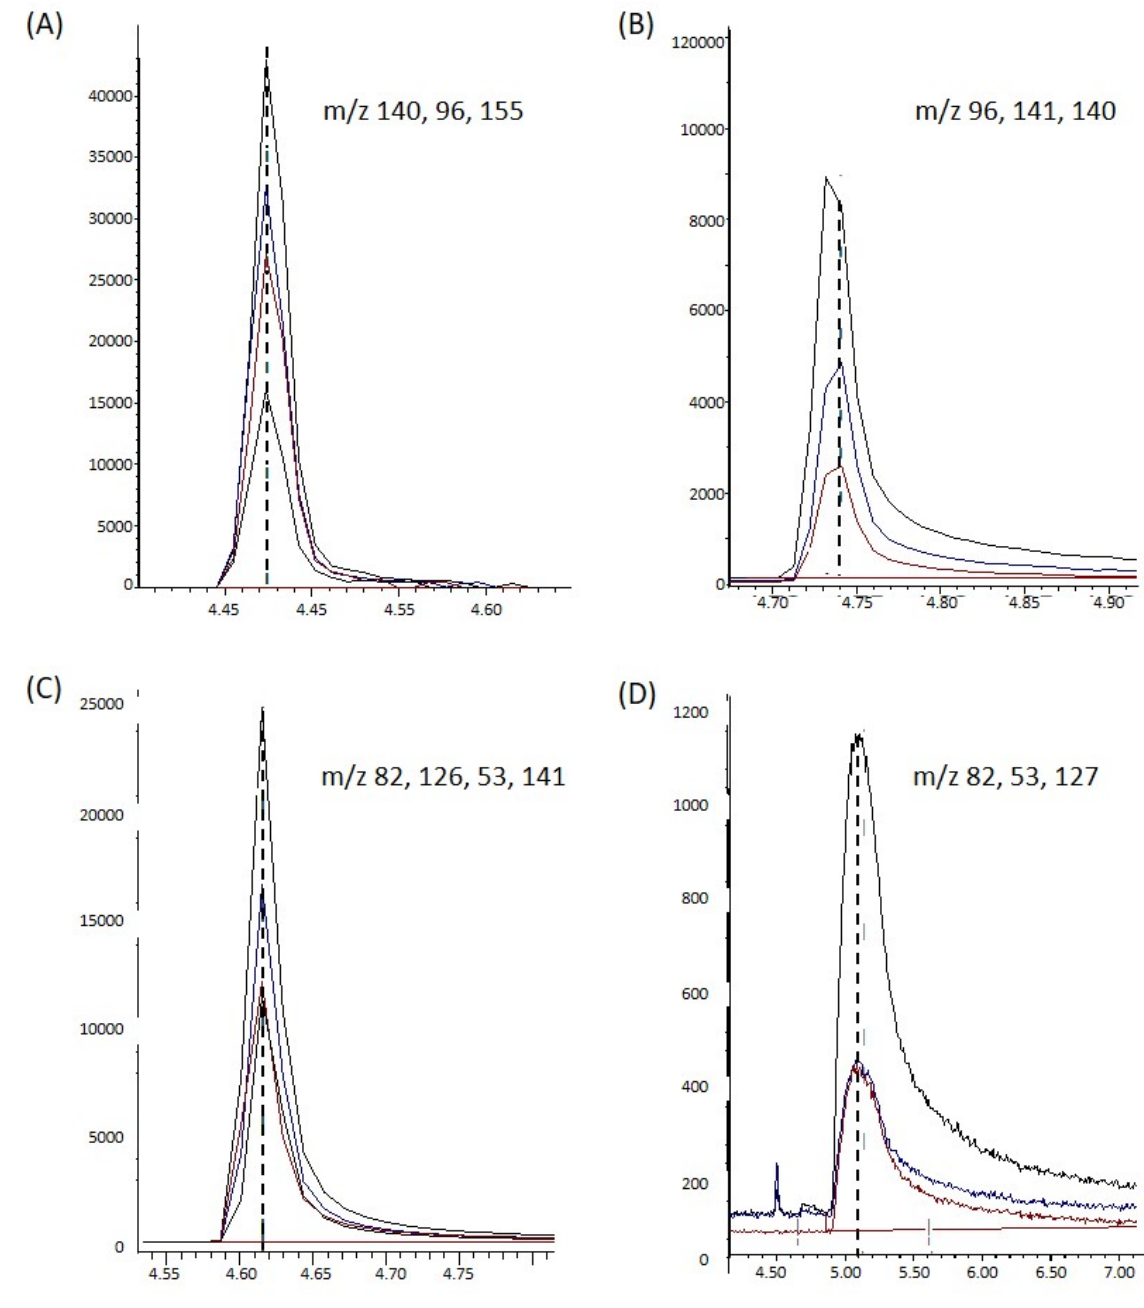
Figure 2. Peaks of alkaloids; ( A ) arecoline, ( B ) arecaidine, ( C ) guvacoline, and ( D ) guvacine.